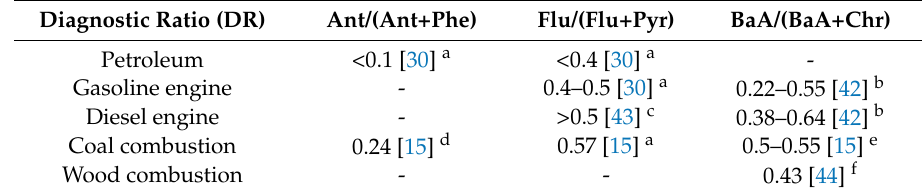
Table 7. Diagnostic ratios of PAHs for samples from previous studies.